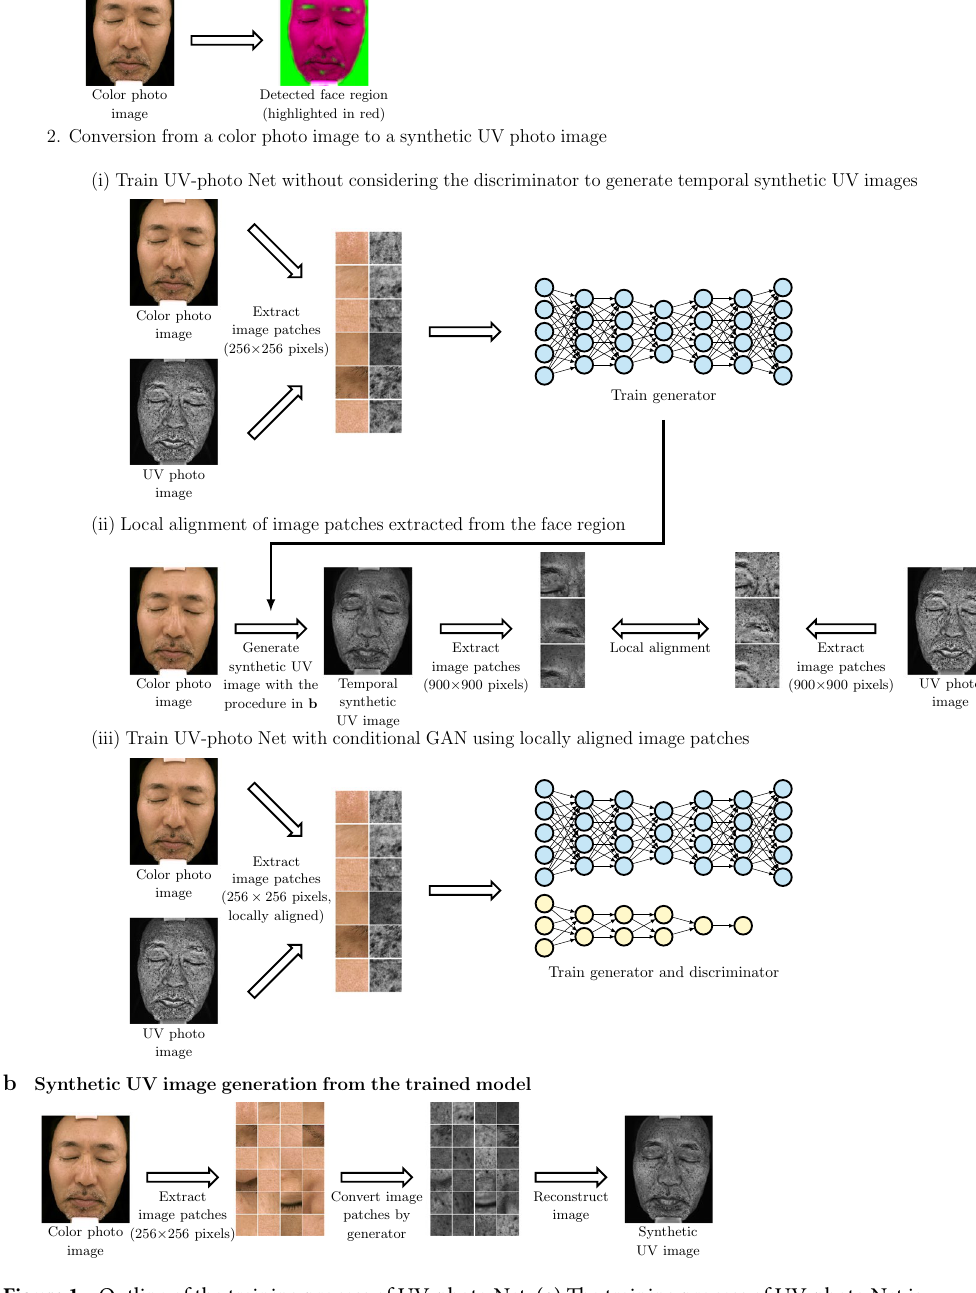
Figure 1. Outline of the training process of UV-photo Net. ( a ) The training process of UV-photo Net is comprised of ( a -1) face region detection, ( a -2-i) training for temporal synthetic UV image generation, ( a -2-ii) local alignment of temporal synthetic UV images and UV photo images, and ( a -2-iii) training under CGAN using locally aligned image patches. ( b ) Synthetic UV image generation from color photo images by assembling the image patches converted by UV-photo